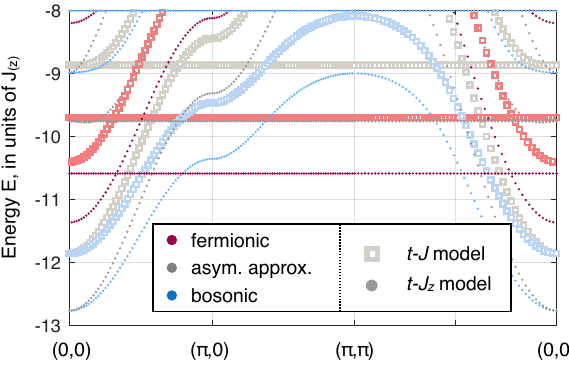
Figure 17: Two-hole spectrum as in Fig. 6, but for t / J = 11, and assumed a string potential for an Ising background. string length ℓ max